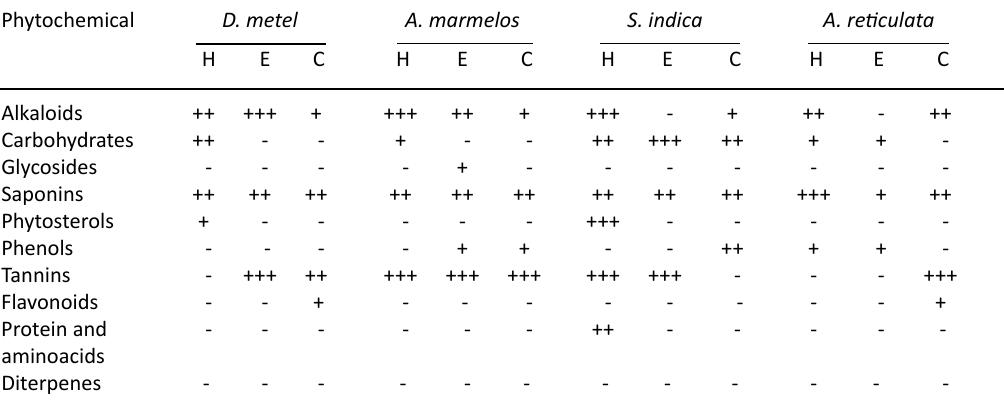
Table 1. Phytochemical analysis of medicinal plants chosen for this study Phytochemical